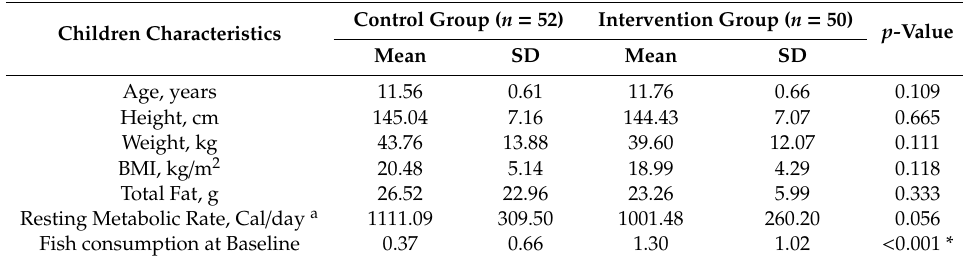
Table 1. Children